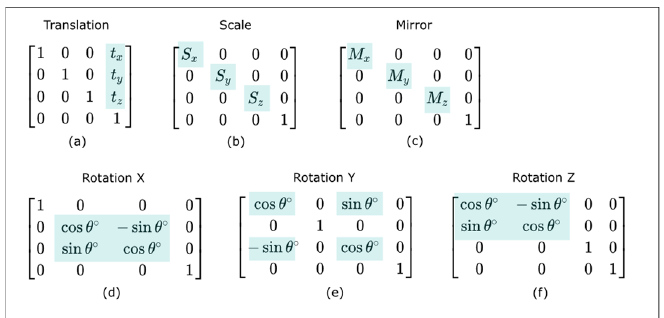
Figure 1. Transformations matrices: ( a ) Translation, ( b ) Scale, ( c ) Mirror or reflection, ( d ) Rotation on X axis, ( e ) Rotation on Y axis, ( f ) Rotation on Z axis. A vertex is represented with a 4 × 1 matrix. Vertex transformation is done when